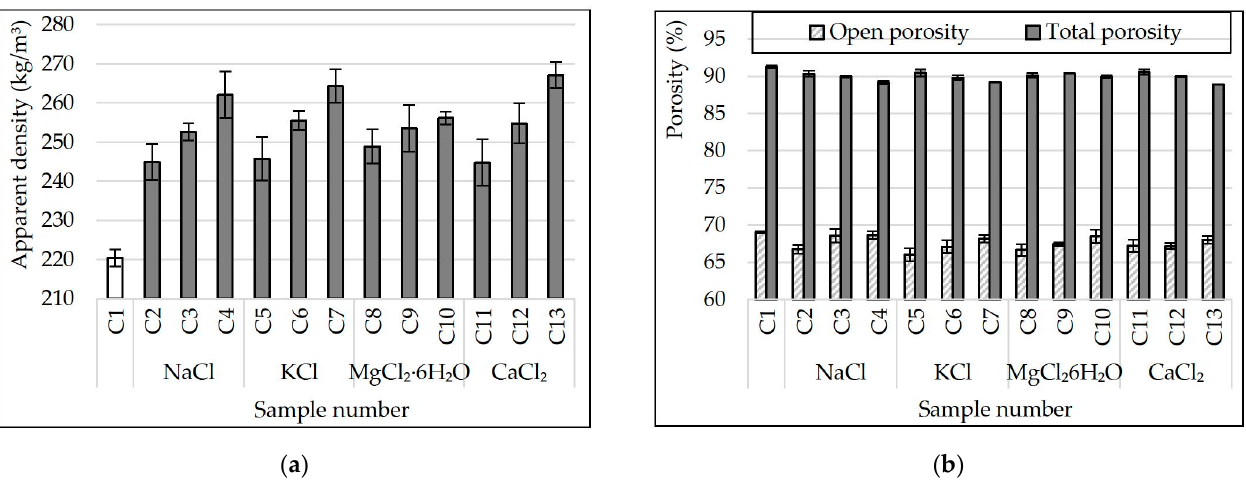
Figure 5. Apparent density ( a ) and porosity ( b ) of samples.